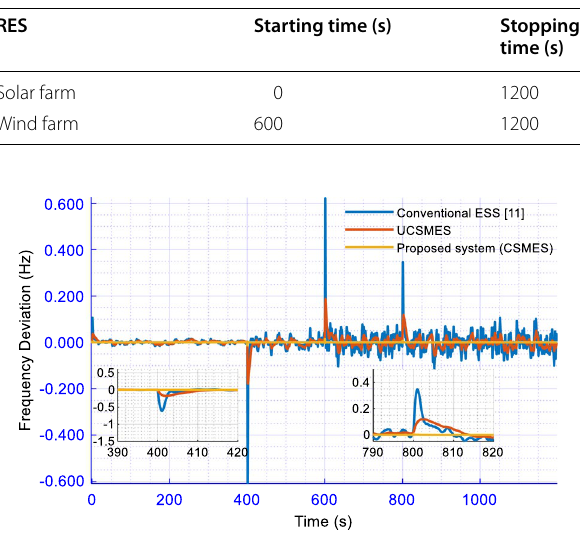
Fig. 12 Frequency deviation of the considered system for scenario 2 at 100% of system inertia